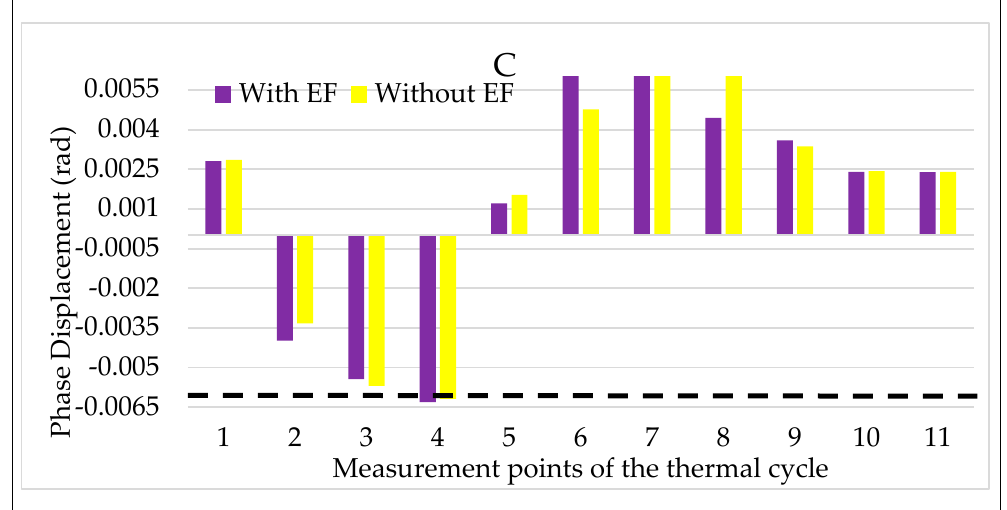
Figure 18. Phase displacement vs. temperature + electric field for LPVT C.